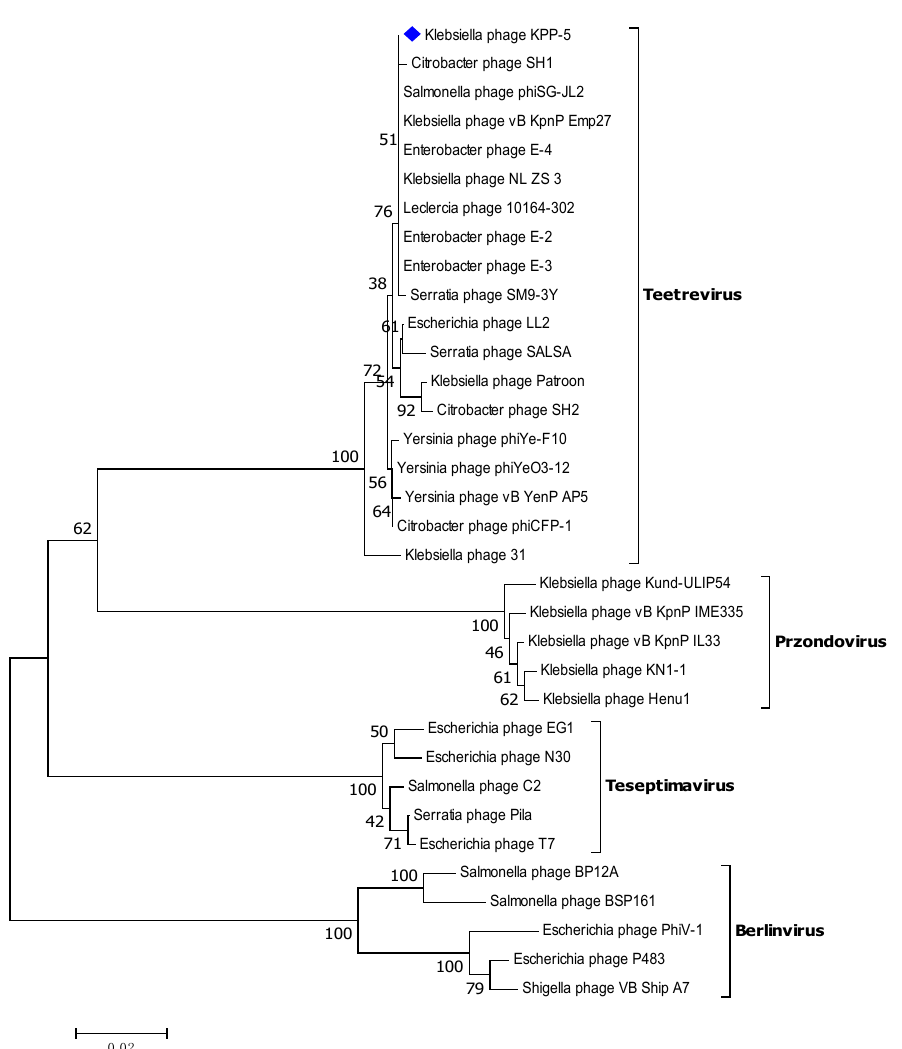
Figure 9. Neighbor-joining tree of Klebsiella phage KPP-5 compared to other phages available in GenBank based on the alignment of terminase large subunit amino acid sequences. The numbers represent bootstrap percentage values based on 1000 replicates.